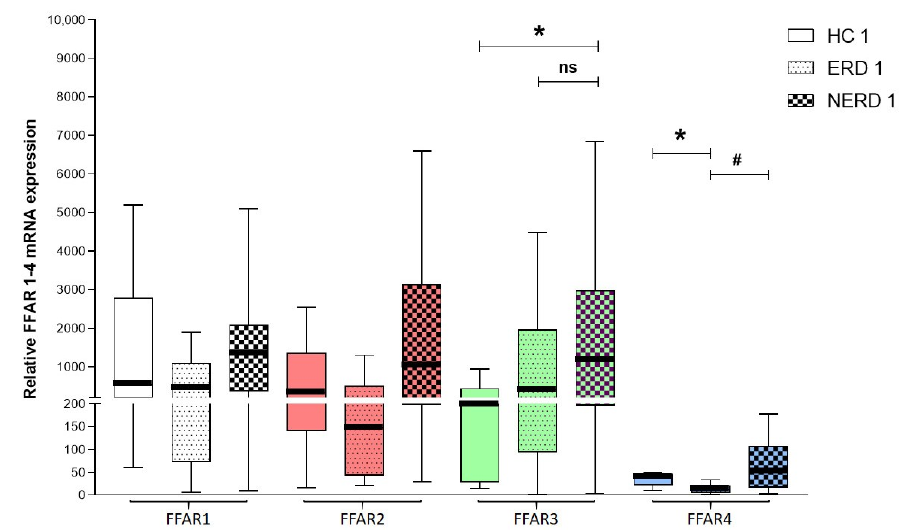
Figure 2. The relative expression of FFAR1, FFAR2, FFAR3, and FFAR4 in HCs (HC1–4, n = 8), patients with erosive reflux disease (ERD) (ERD 1–4, n = 12-15), and patients with nonerosive reflux disease (NERD) (NERD 1–4, n = 32-36). Expression was compared with the HPRT1 reference gene. The Kruskal–Wallis test was used to compare the values. ns – non significant * p < 0.05 as compared to respective control, # p < 0.05 as compared to ERD.